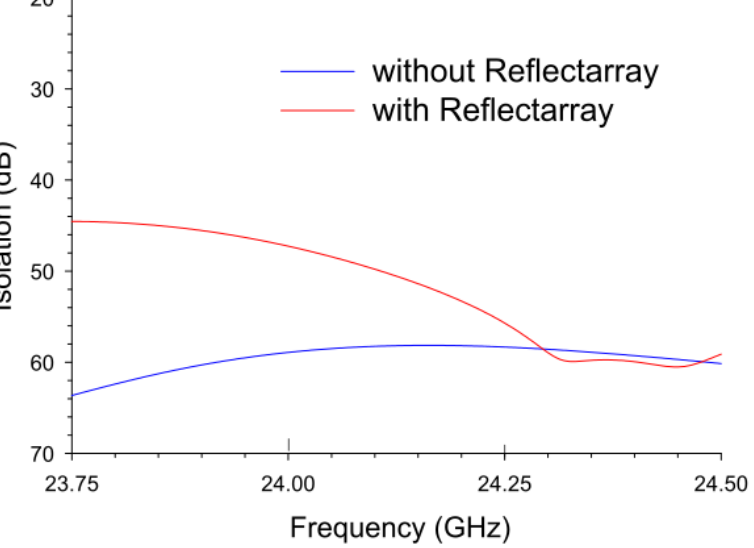
Figure 7. The average of simulated transmission coefficients between the four transmitting antennas and the receiving antenna without and with the presence of the reflectarray